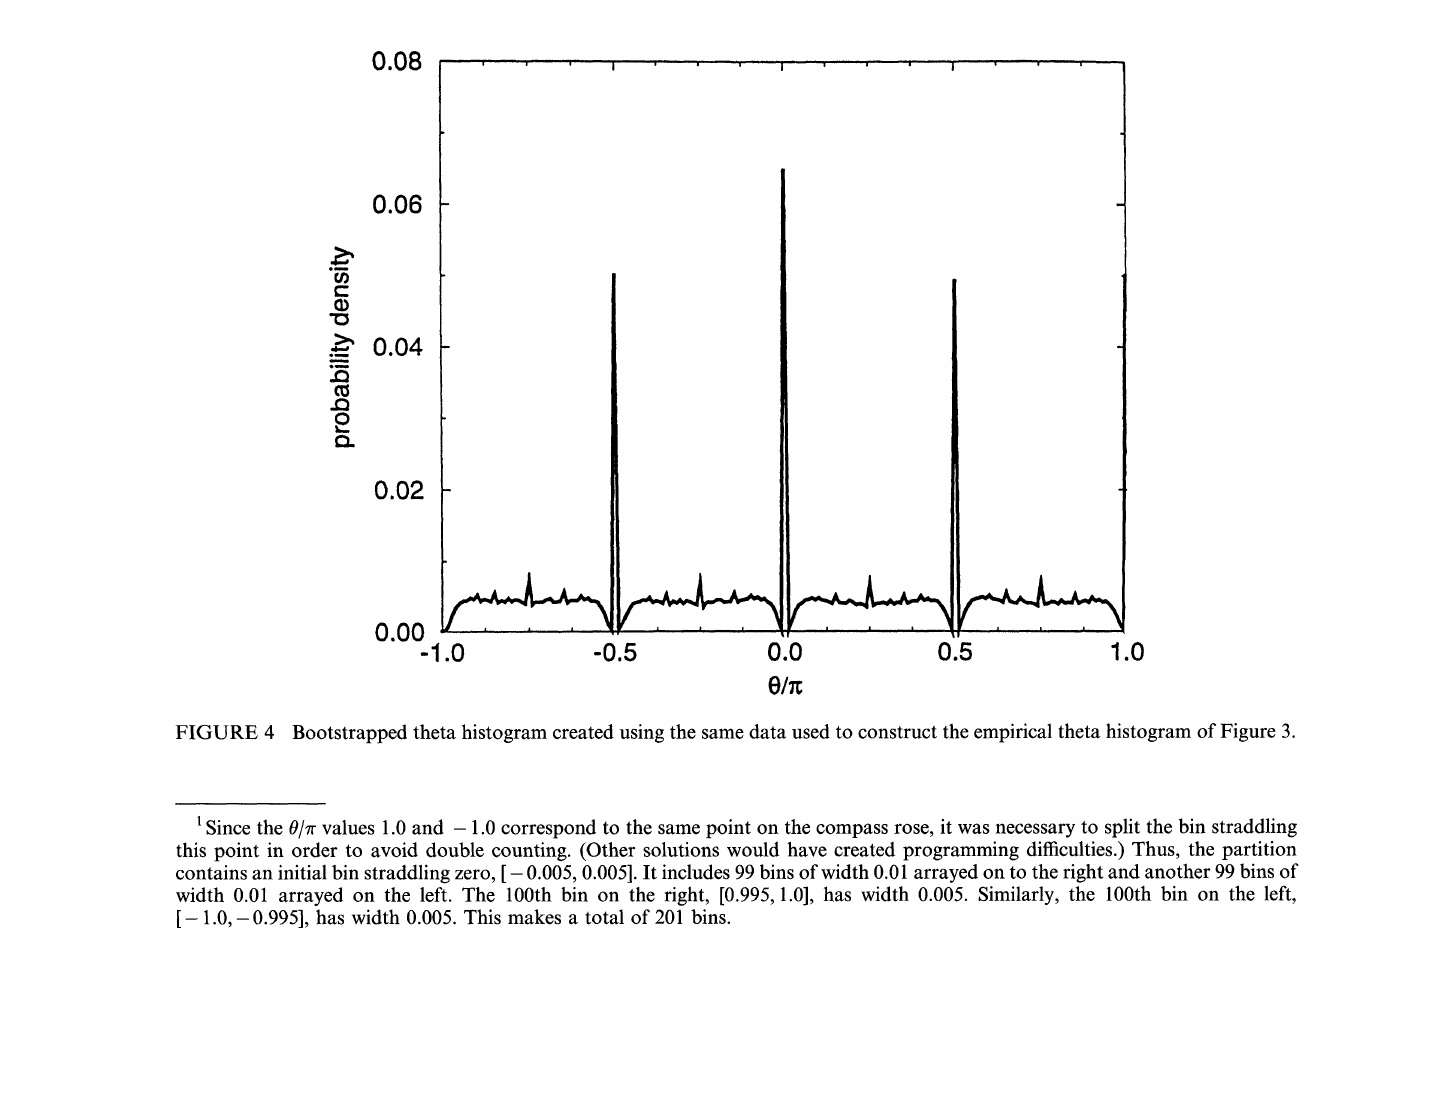
Since the 0/r values 1.0